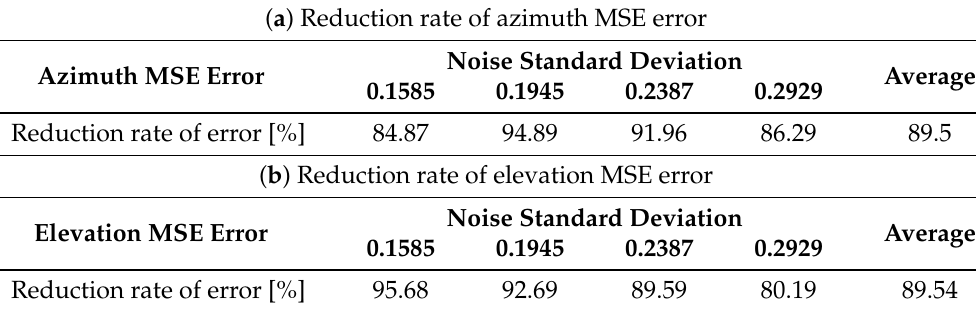
Table 5. MSE error reduction rate of “Analytic MSE (approx =